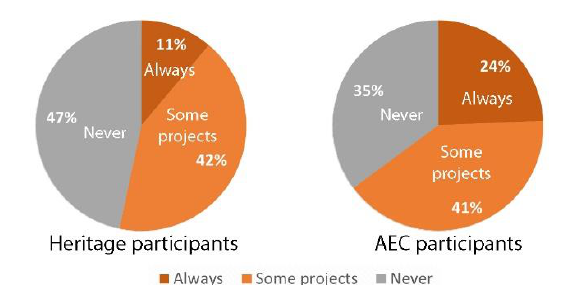
Figure 3: Responses of participants on whether they use BIM in their projects.